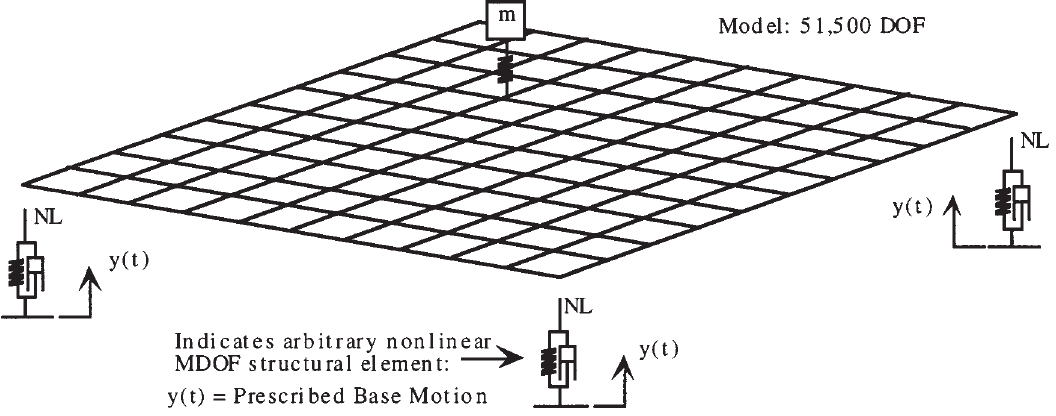
Fig. 2. Isolated deck model – 51,500 DOF – isolators: nonlinear stiffness, linear